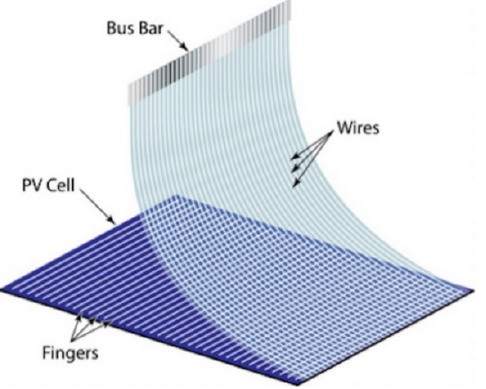
Figure 3. SmartWire connections applied to the photocell, reprinted from [64].